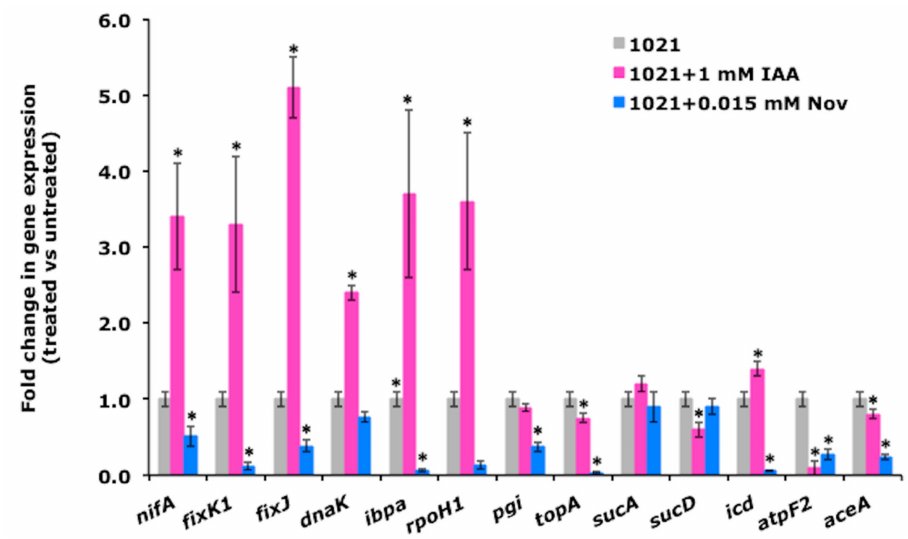
Figure 5. Alterations in DNA supercoiling mediated by IAA stimulate the expression of genes involved in nitrogen-fixation and stress response. Quantitative measurement of the nifA, fixK1, fixJ, dnaK, ibpa, rpoH1, pgi, and topA transcript levels in novobiocin- and IAA-treated cultures after 2 h of treatment. Values are the means ± SD of four di ff erent biological replicates. The asterisks (*) indicate significant di ff erences ( p < 0.05, one-way ANOVA with Tukey’s post-hoc test) between the control and treated cells. Nov, novobiocin.